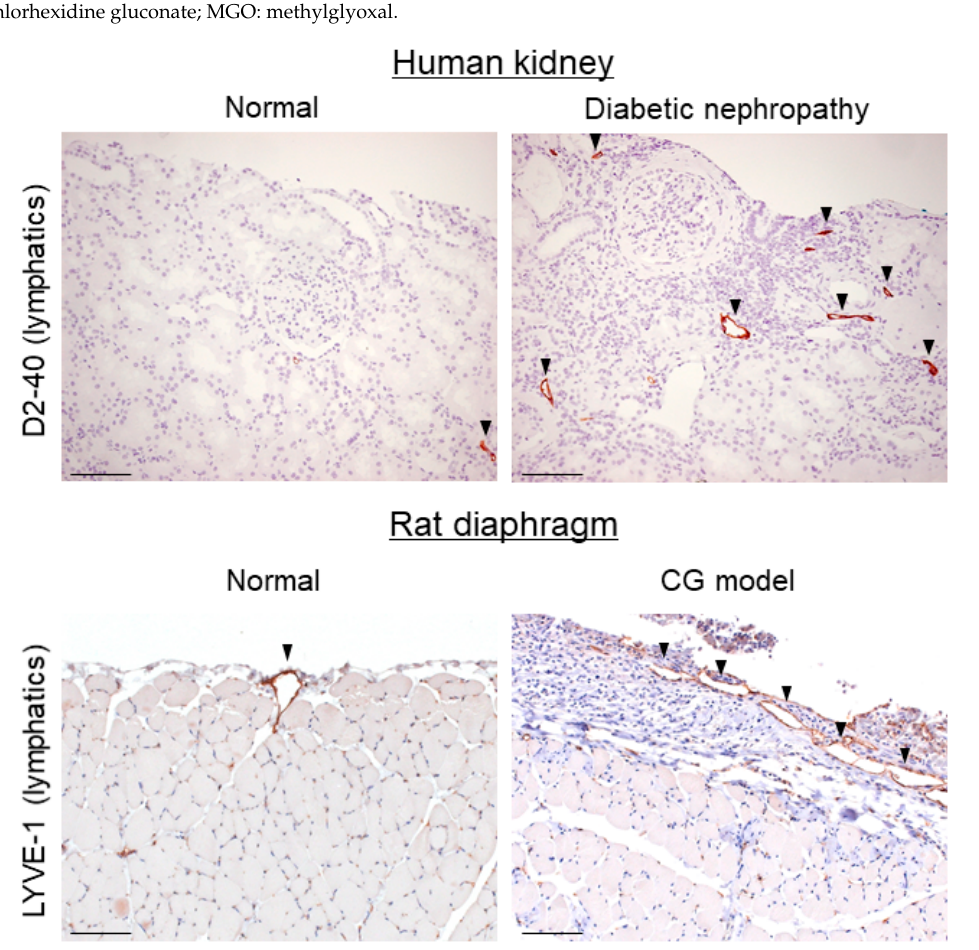
Table 1. Lymphangiogenesis in fibrotic diseases.